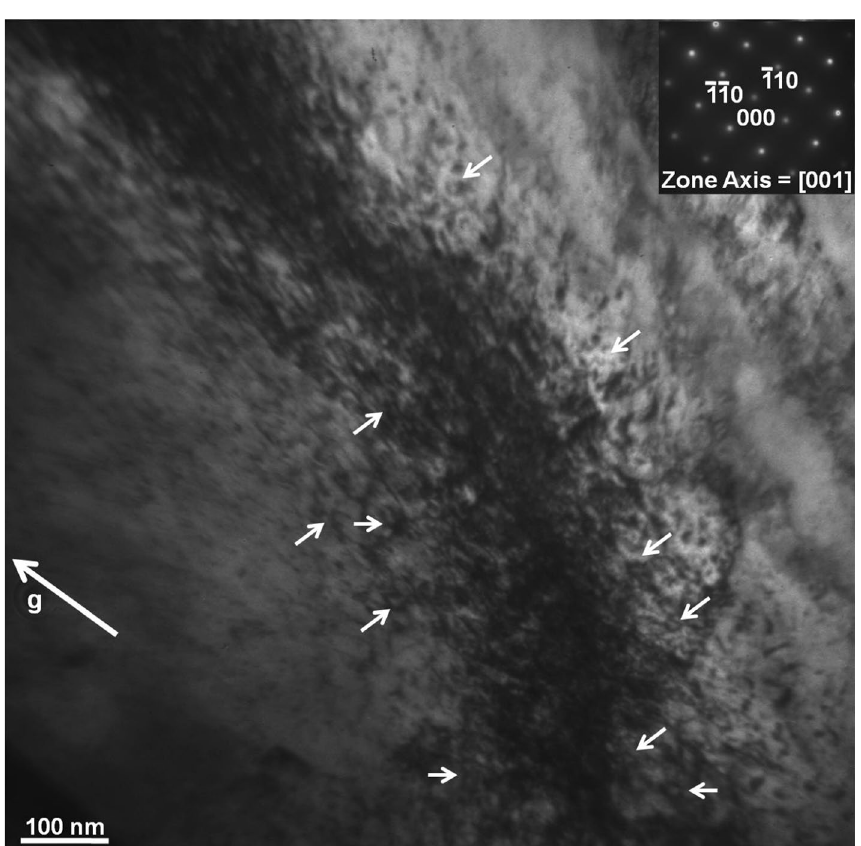
Figure 13. Bright-field TEM micrograph of the steel sample showing the damage structure generated upon irradiation (0.2 dpa) at 77 K temperature. The dislocation loops are marked by small arows. The diffraction conditions used for imaging are provided as inset in form of diffraction pattern and